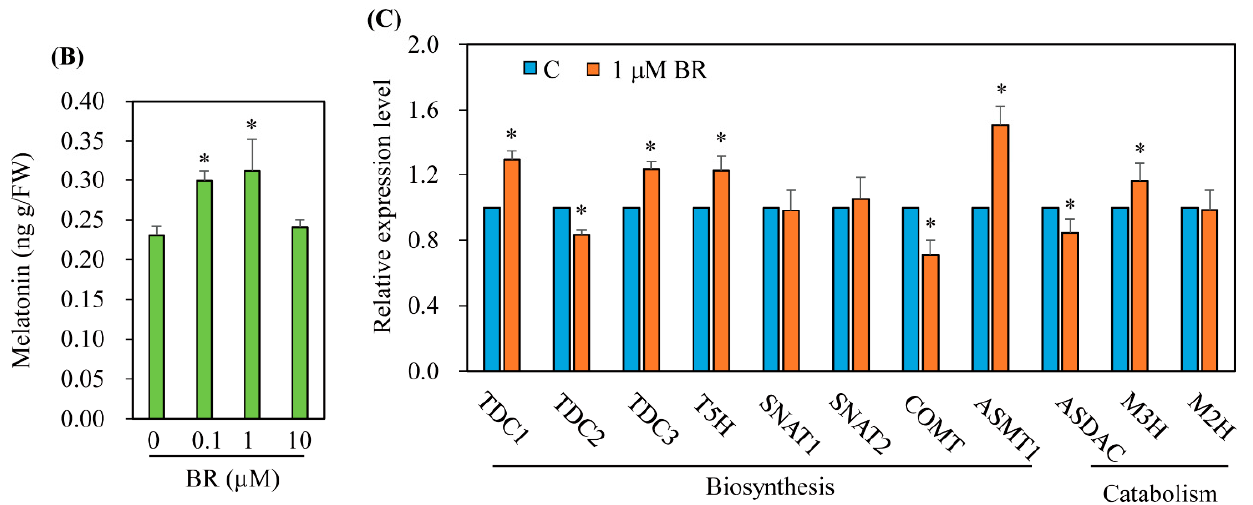
Figure 2. ( A ) Pathways of melatonin biosynthesis and catabolism. ( B ) Melatonin levels in rice seedlings treated with brassinosteroid in the absence of cadmium treatment. ( C ) Expression levels of transcripts encoding melatonin biosynthetic and catabolic genes. Seven-day-old rice seedlings were treated rhizosperically with various concentrations of epibrassinolide (BR) for quantification of melatonin or with 1 µ M epibrassinolide (BR) for qRT-PCR for 24 h. The upper parts of leaves and stems were collected for HPLC quantification of melatonin and qRT-PCR analysis of various genes involved in melatonin synthesis and catabolism. The primer sequences were previously described [20]. C, water containing 0.1% ethanol. Asterisks (*) denote significant differences ( p < 0.05; ANOVA, followed by Tukey’s HSD post hoc tests). C, water containing 0.1% ethanol; BR, epibrassinolide; TDC1